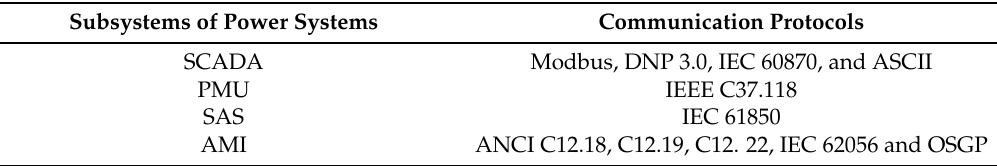
Table 1. Latest version of communication protocols.